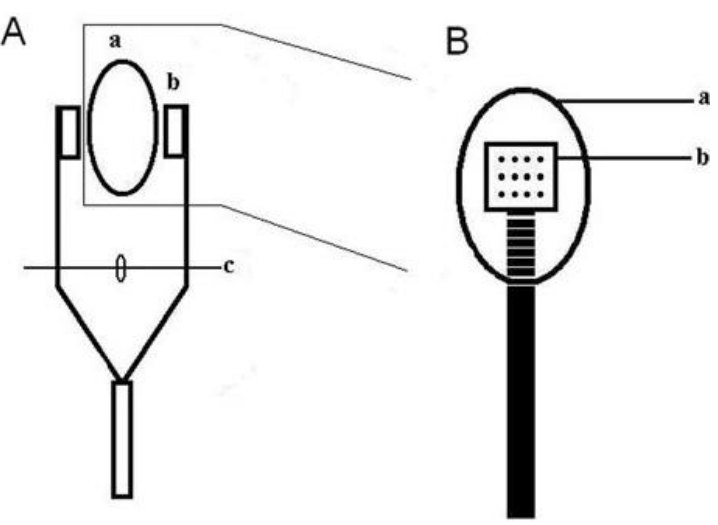
FIGURE 2. Graphic depiction of the measuring device of the ETRT. (A) Lateral view of the instrument: the testis model is ―captured‖ by the instrument. (B) Sagittal section of A (magnified and rotated 90° around the vertical axis) showing the microsensors (black dots) that come into contact with the model. a, Testis model; b, tactile sensor; c, shaft controlling the compaction of the model.